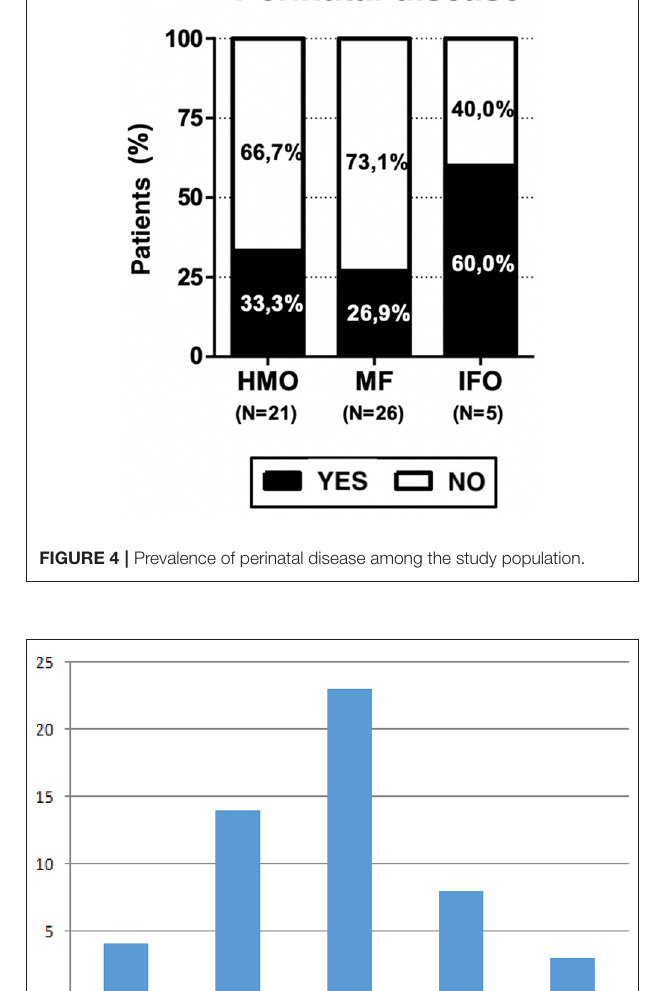
physiological jaundice, but in any case, the Apgar score was at least